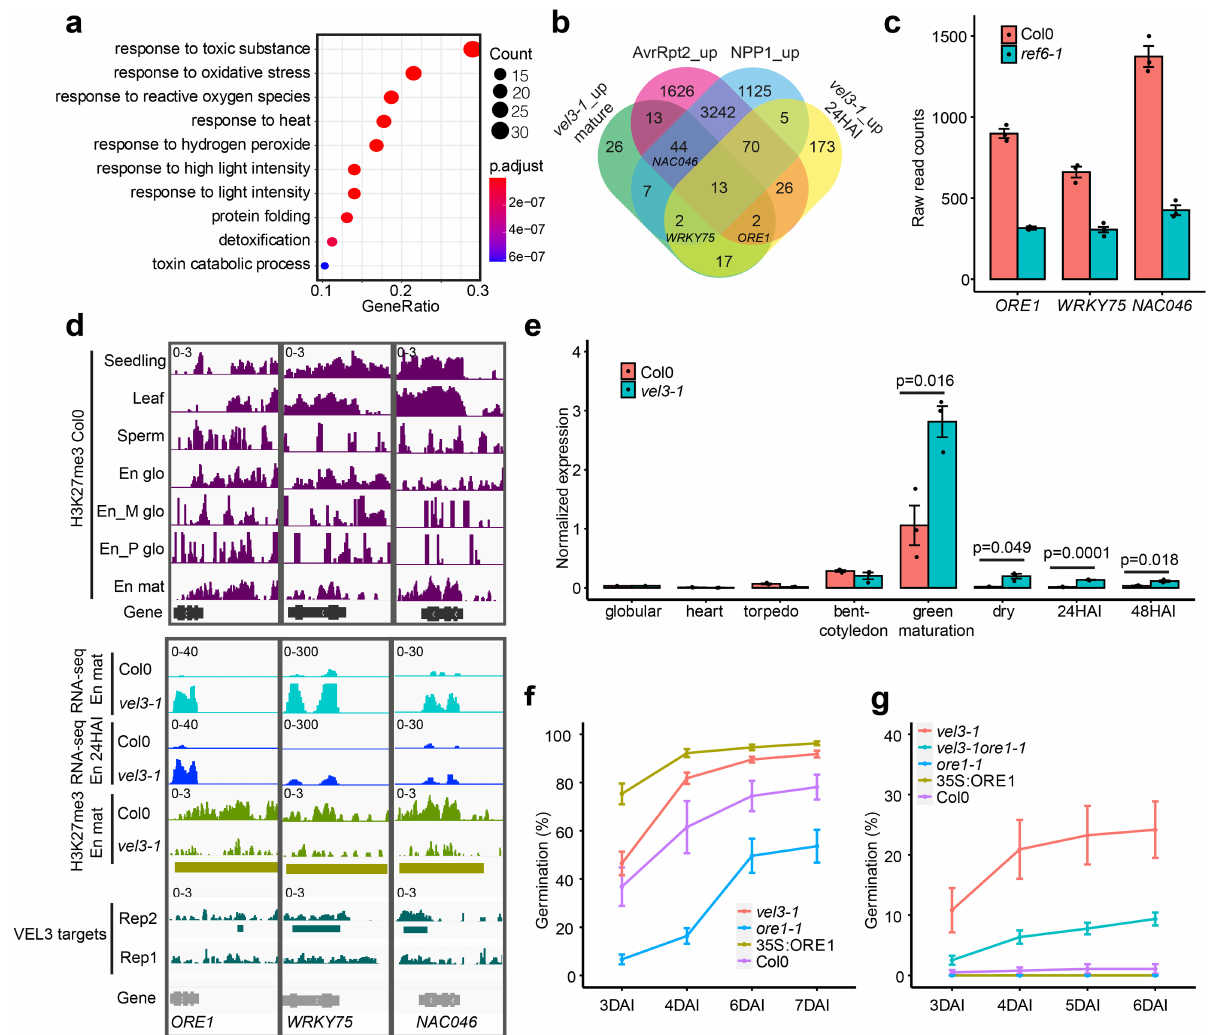
Fig. 5 | VEL3isrequiredfor the repressionofsenescence and programmedcell death-associated gene expression in the endosperm with a role in seed dor- mancy control. a GO-Term analysis of genes upregulated in mature vel3-1 seeds comparedtoCol-0whensetat16°C,showinggenefunctioncategory, p -valuesand number of mis-expressed genes in each category. p -values are derived from the one-sided Fisher ’ s exact test. b Comparison of upregulated genes in vel3-1 in the mature endosperm and 24h after imbibition (24HAI) and genes upregulated by Pseudomonas syringae and Phytophthora parasitica effector proteins causing pro- grammed cell death, after Tomastikova et al. 24 . c Three key senescence-regulating transcription factors are also upregulated by loss of REF6, asshown by RNA-seq in mature Col-0 and ref6-1 endosperm. Data represent mean and standard error of threebiologicalreplicates(datafromSatoetal.) 11 . d AnalysisoftheroleofVEL3and H3K27me3 in the regulation of ORE1 , WRKY75 and NAC046 in seeds set at 16°C. Levels of H3K27me3 are shown at in different tissues, including the maternally derived and paternally derived alleles in the endosperm (Moreno Romero et al. 3